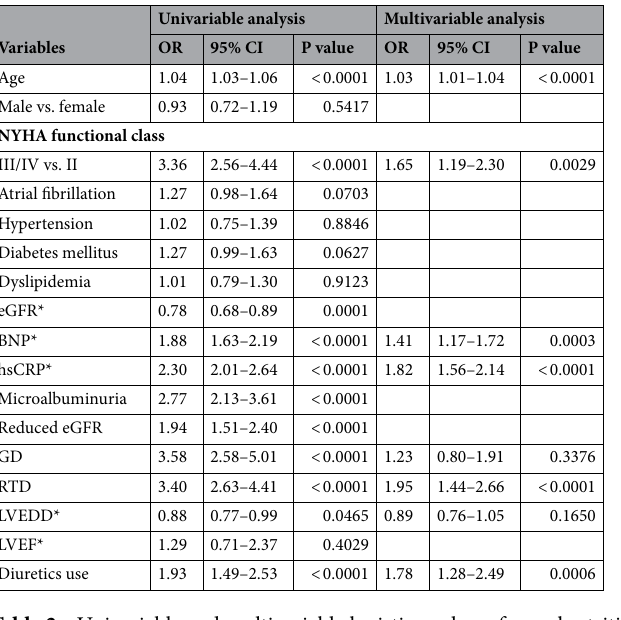
Table 2. Univariable and multivariable logistic analyses for malnutrition defined by high CONUT score. *Per 1-SD increase. BNP brain natriuretic peptide, CI confidence interval, CONUT controlling nutritional status, eGFR estimated glomerular filtration rate, GD glomerular damage. OR odds ratio, hsCRP high sensitivity C-reactive protein, LVEDD left ventricular end diastolic dimension, LVEF left ventricular ejection fraction,